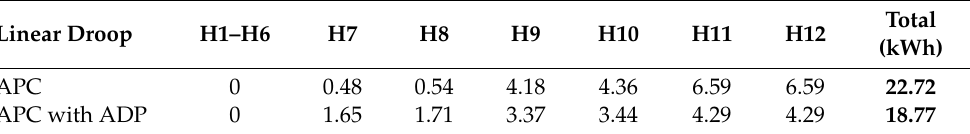
Table 2. Energy curtailed (kWh) for twelve houses with Linear droop.